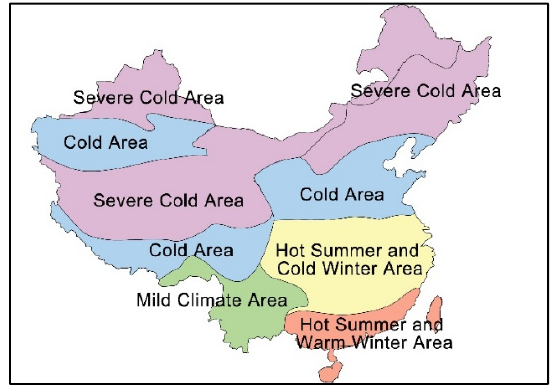
Figure 1. Architectural climate zoning map of China.